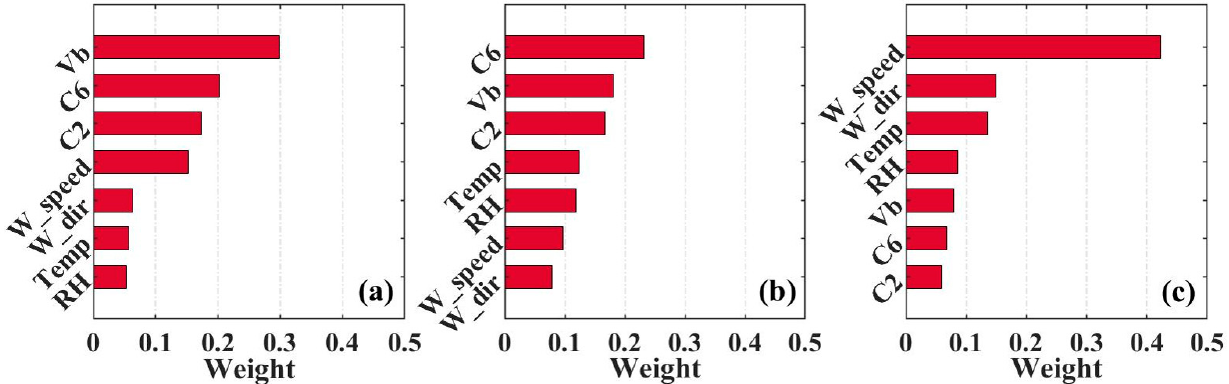
Figure 5. The importance factors ranking of distinguishing ( a ) other situations vs. blowing snow, ( b ) other situations vs. fog and ( c ) blowing snow vs. fog in the training set.